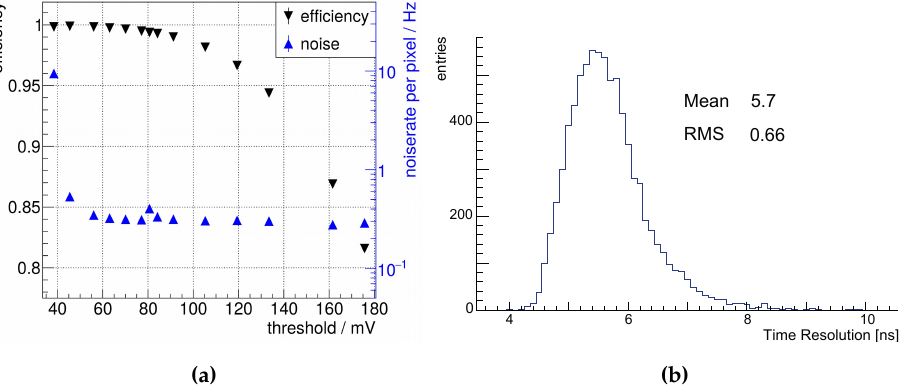
Figure 8. ( a ) Efficiency and noise vs threshold for a M U P IX 8 chip obtained in test beam. ( b ) Distribution of the measured M U P IX 8 time resolutions of individual pixels obtained with the 2- comparator threshold method and after time-walk correction using a 90Sr source [1].